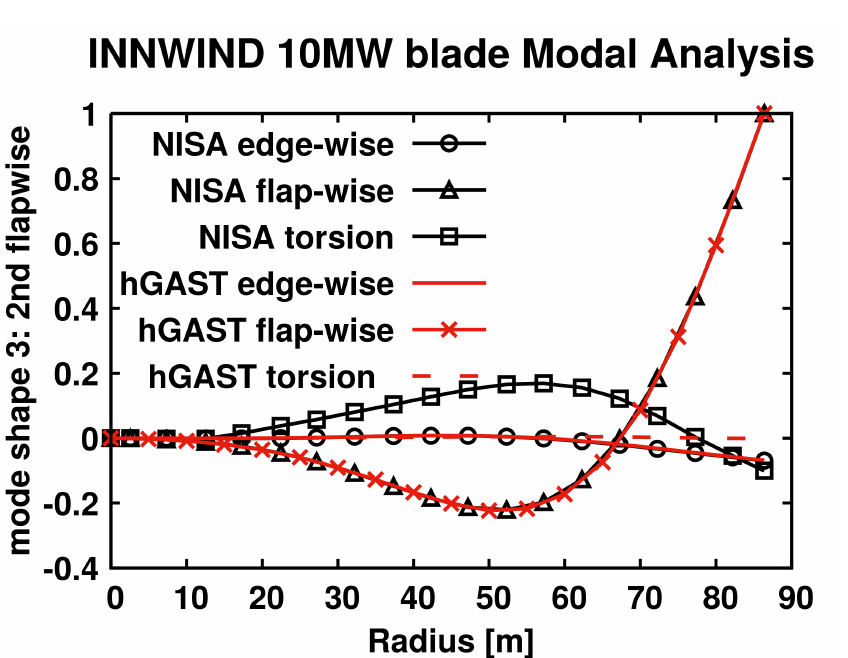
Figure 15. Mode shape of 1st flapwise